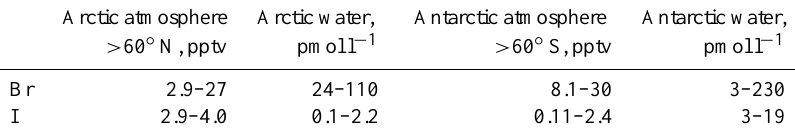
Table 2. Mixing ratios and surface water concentrations of organo-Br and organo-I. Data taken from: Carpenter et al. (2007), Yokouchi et al. (1996, 1994, 2008, 2001), Butler et al. (2007), Penkett et al. (1985), Reifenh¨auser and Heumann (1992a,b), Bottenheim et al. (1990), Rasmussen et al. (1982), Hughes et al. (2009), Krysell (1991), Fogelqvist (1985), Fogelqvist and Tanhua (1995), Moore and Tokarczyk (1993); Moore et al. (1993), Sturges et al. (1997), Schall and Heumann (1993); Schall et al. (1997), Abrahamsson et al. (2004), Chuck et al. (2005). Arctic atmosphere Arctic water, Antarctic atmosphere Antarctic water, > 60 ◦ N, pptv pmoll − 1 > 60 ◦ S, pptv pmoll − 1 Br 2.9–27 24–110 8.1–30 3–230 I 2.9–4.0 0.1–2.2 0.11–2.4